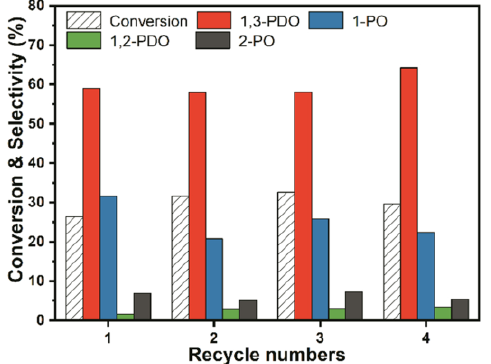
Figure 22. The glycerol conversion and selectivity to liquid products by employing the Pt/Al-WO x catalyst. Reaction conditions: 140 °C, 3 MPa H 2 , 5 wt.% glycerol solution, 4 cycles of 12 h. Reproduced from [98] with permission from Elsevier.